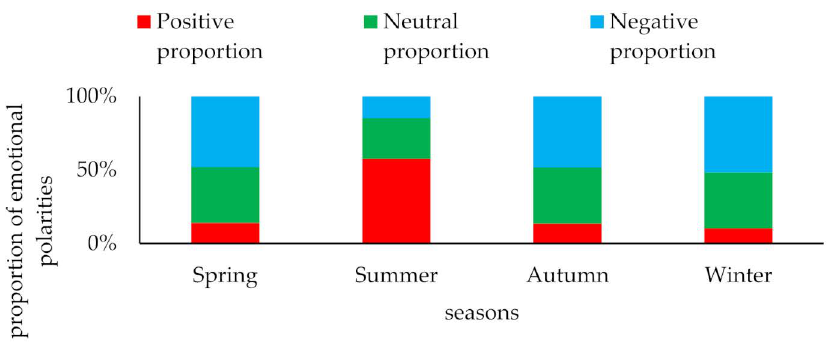
Figure 4. Proportion of emotional polarities by season (%).